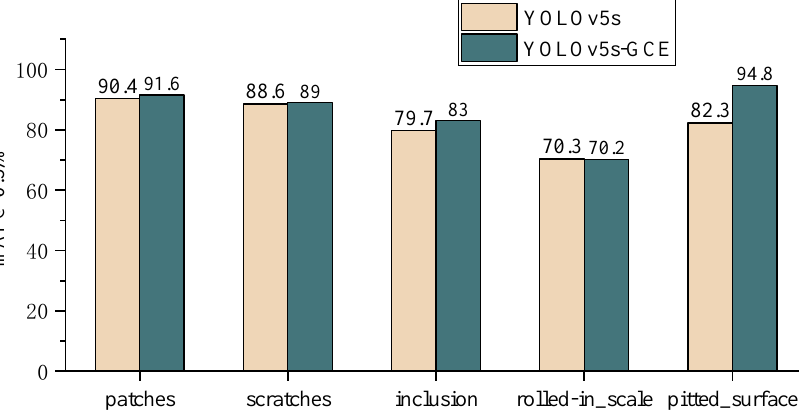
Figure 7. The detection results of various defects.